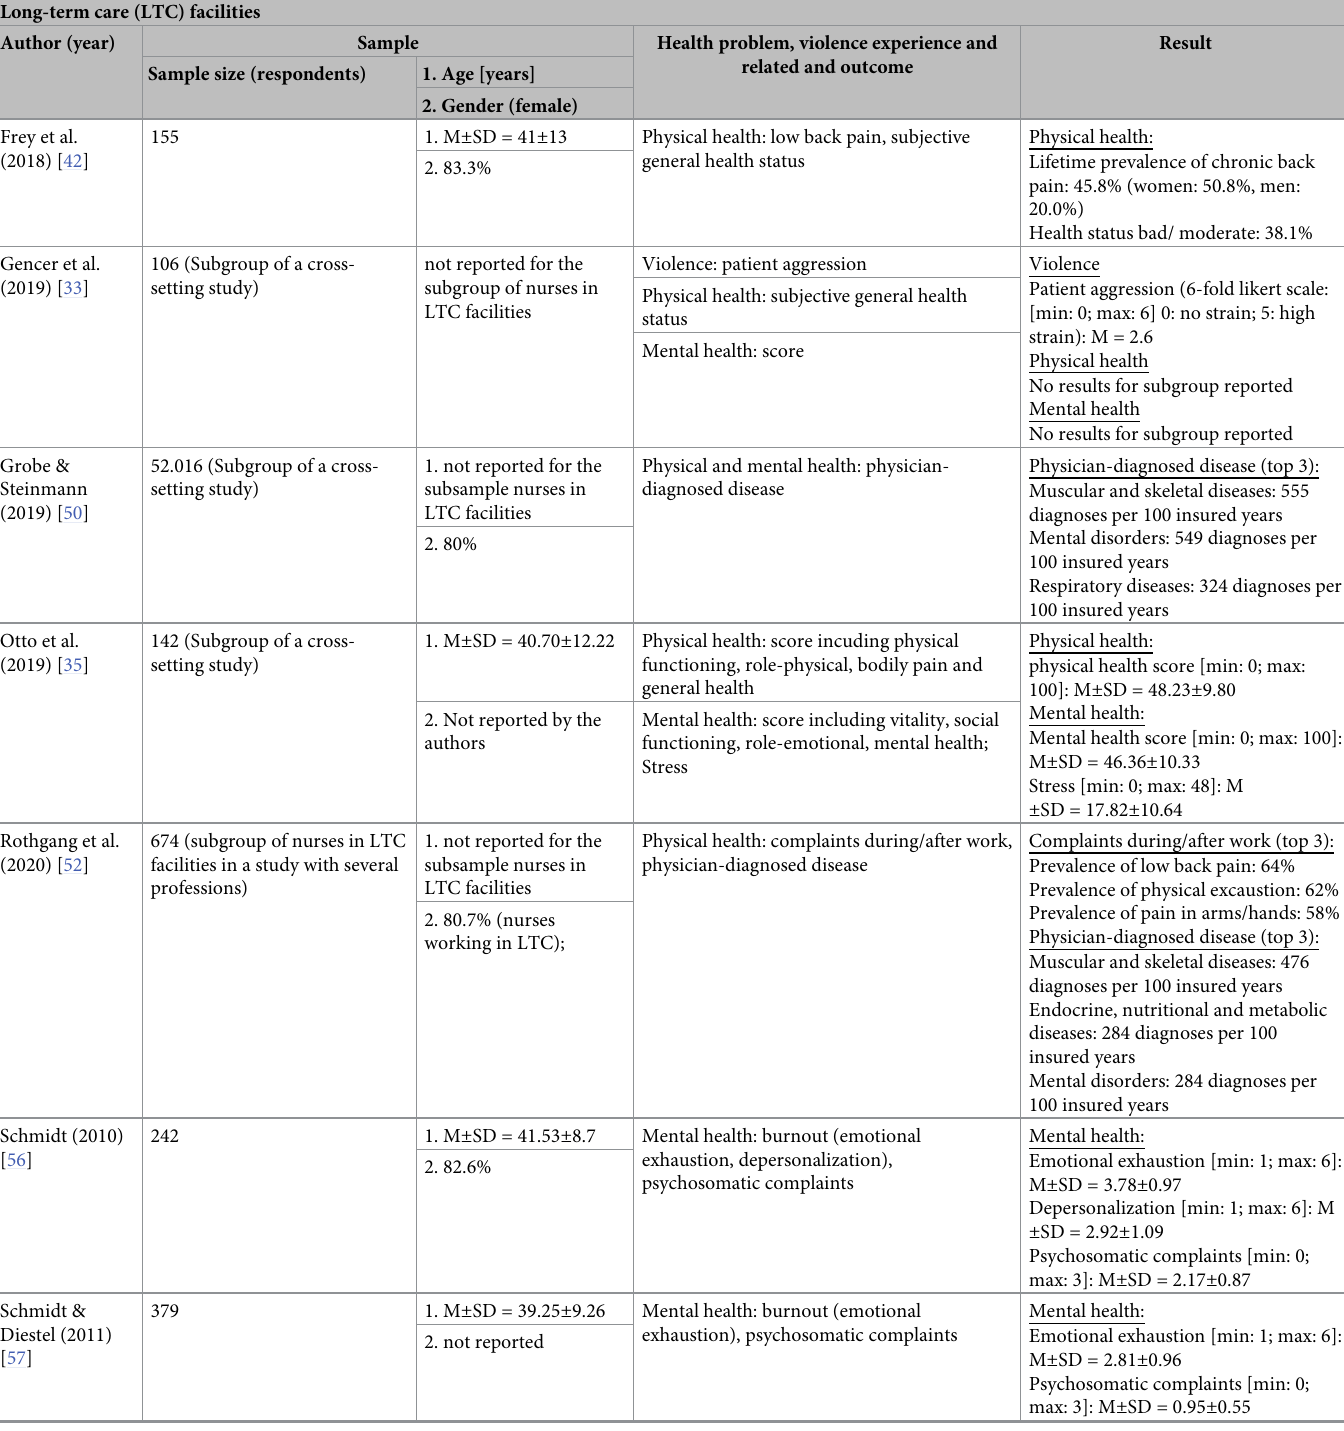
Table 3. Long-term care (LTC) facilities—Summary of the studies included in the review. Long-term care (LTC)